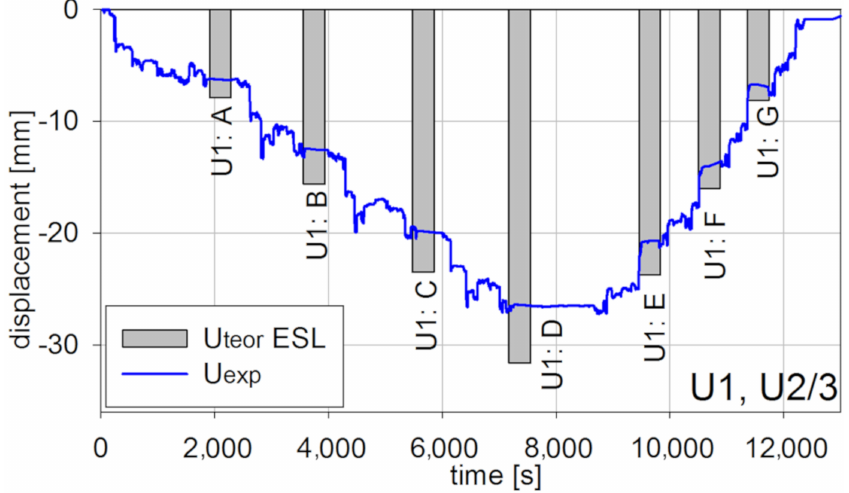
Figure 17. Vertical displacements in U2 / 3 for the U1